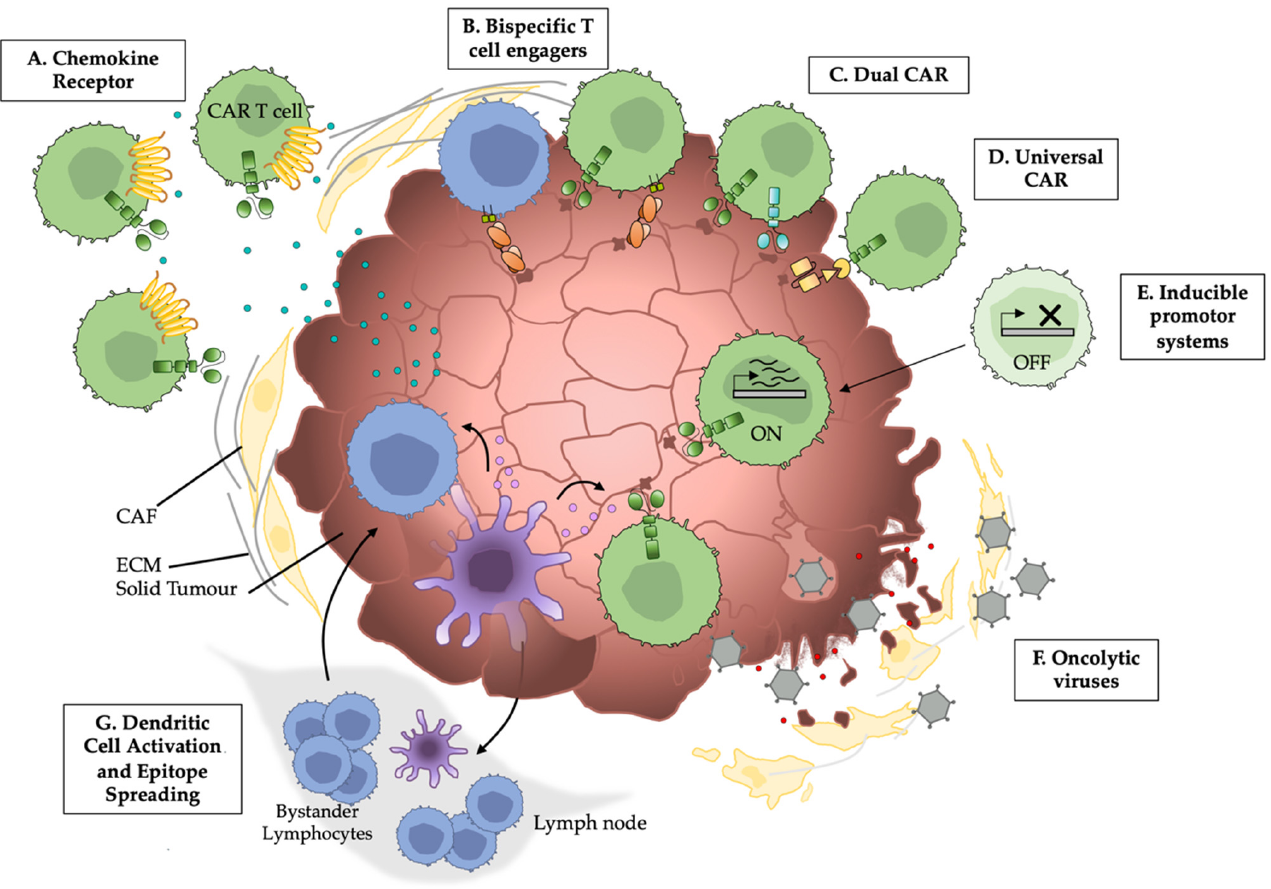
Figure 1. Summary of strategies to combat solid tumour physical barriers to improve CAR T/NK cell trafficking and activation. A–G represent examples of approaches to enhance the CAR T/NK cell targeting of solid tumours reviewed